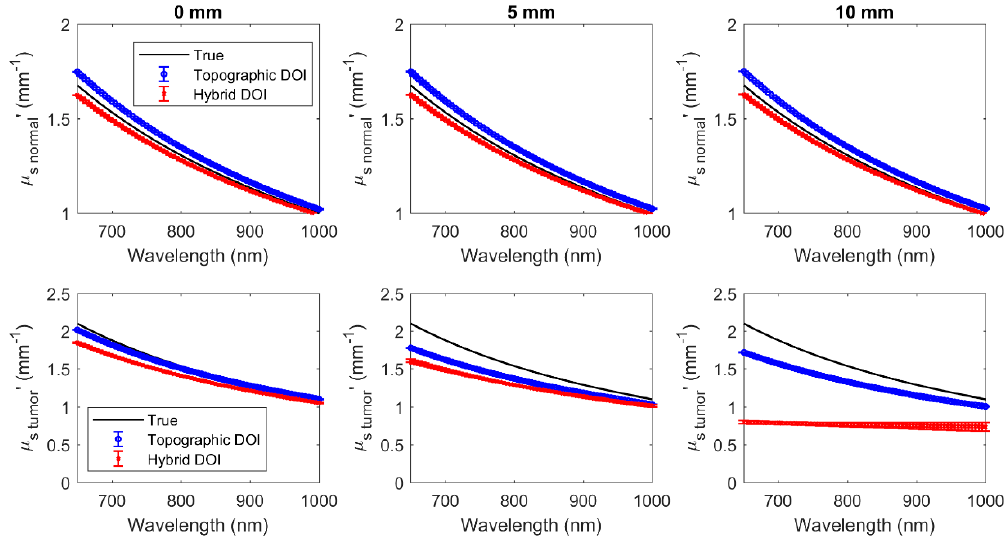
Figure 10. Hyperspectral normal (row 1) and tumor µ s (cid:48) (row 2) at wavelengths 650 nm to 1000 nm at di ff erent tumor depths (columns). Table 3. Mean di ff erence and mean percentage di ff erence of recovered ( µ a , µ s (cid:48) ) from true ( µ a , µ s (cid:48) ) over all